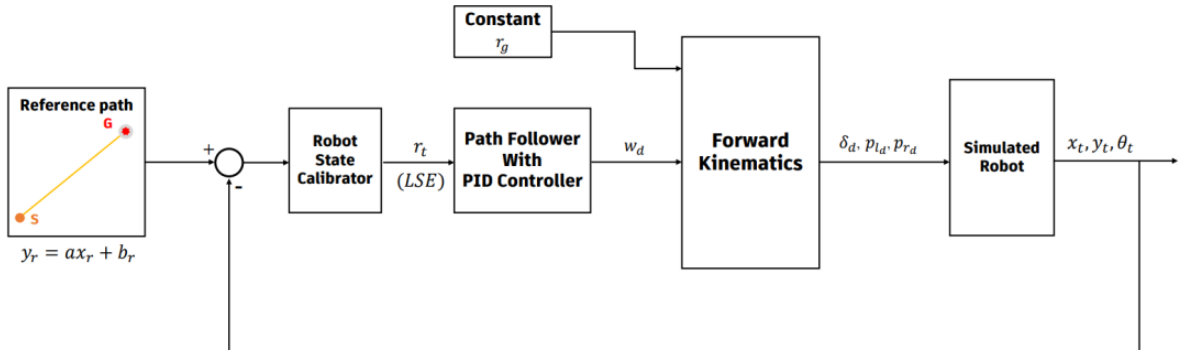
Figure 26. Control loop of the path follower based on the PID controller.